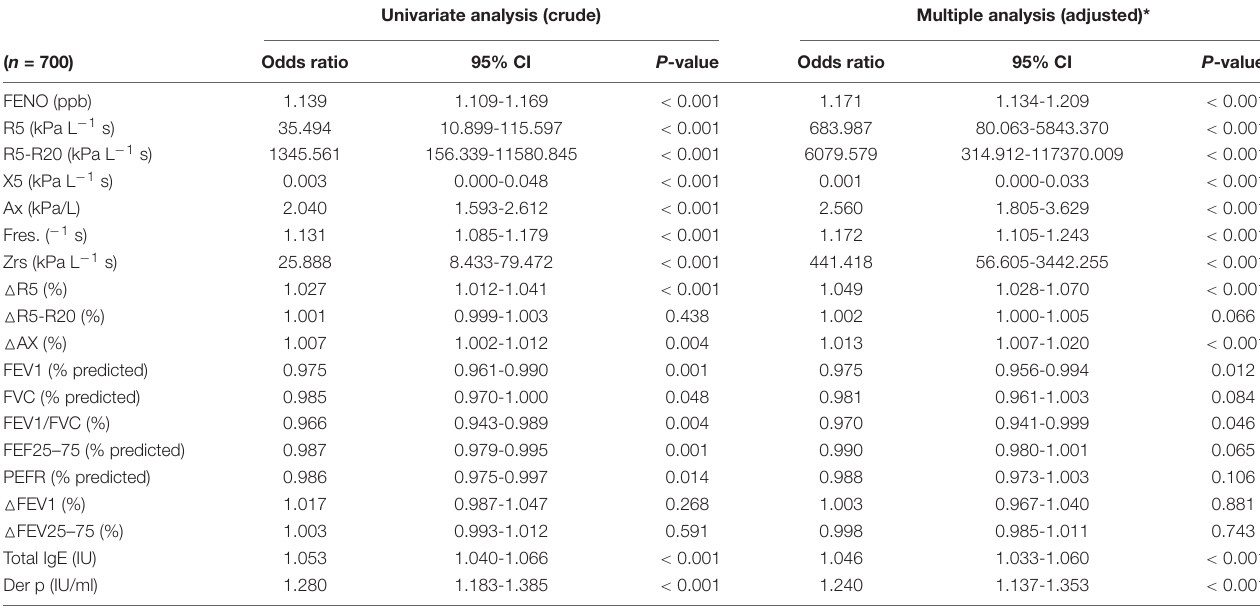
TABLE 2 | Logistic regression analysis of asthma diagnosis.